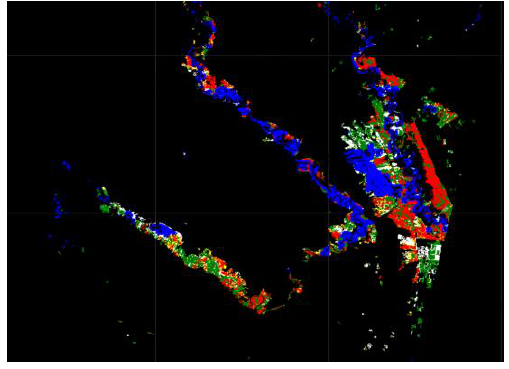
Figure 7. Flooded land uses.